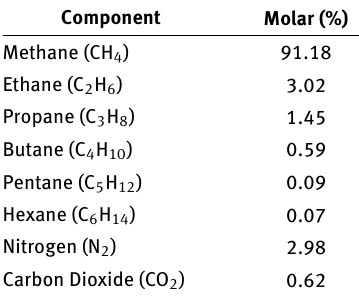
Table 2: Components of CNG.